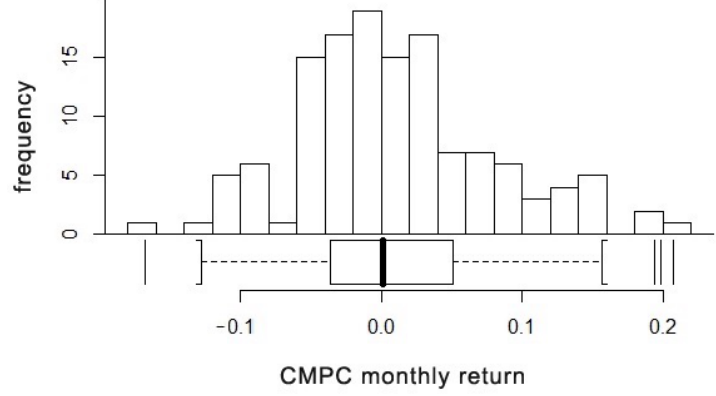
Figure 2. Histogram and box plot of CMPC monthly returns.